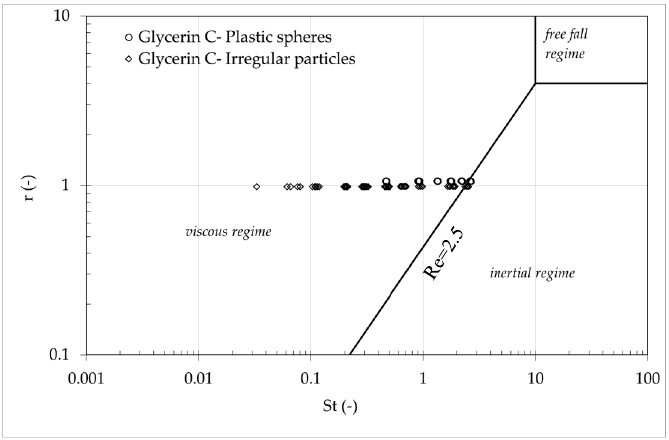
Figure 4. Different flow regimes in the St-r diagram based on [19] for the data set from Schippa and Lamberti [30] on plastic spherical particles and plastic irregular particles dispersed in water–glycerol solutions.